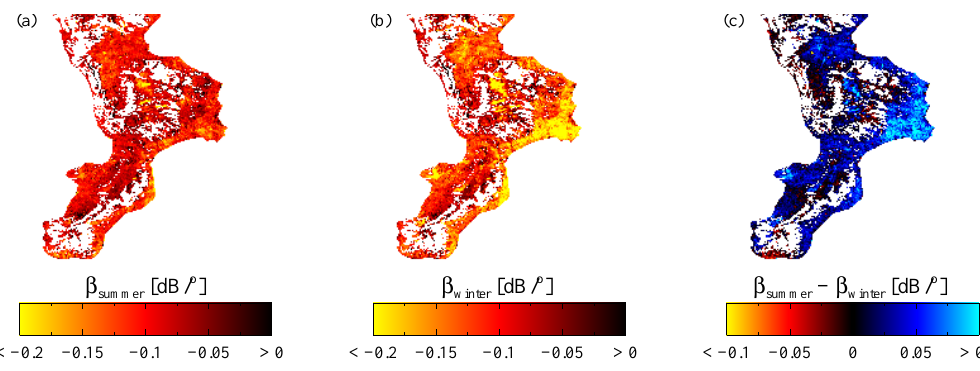
Fig. 8. Angular correction coefficient for the summer months β summer (a) , winter months β winter (b) and the difference between β summer and β winter (c) .